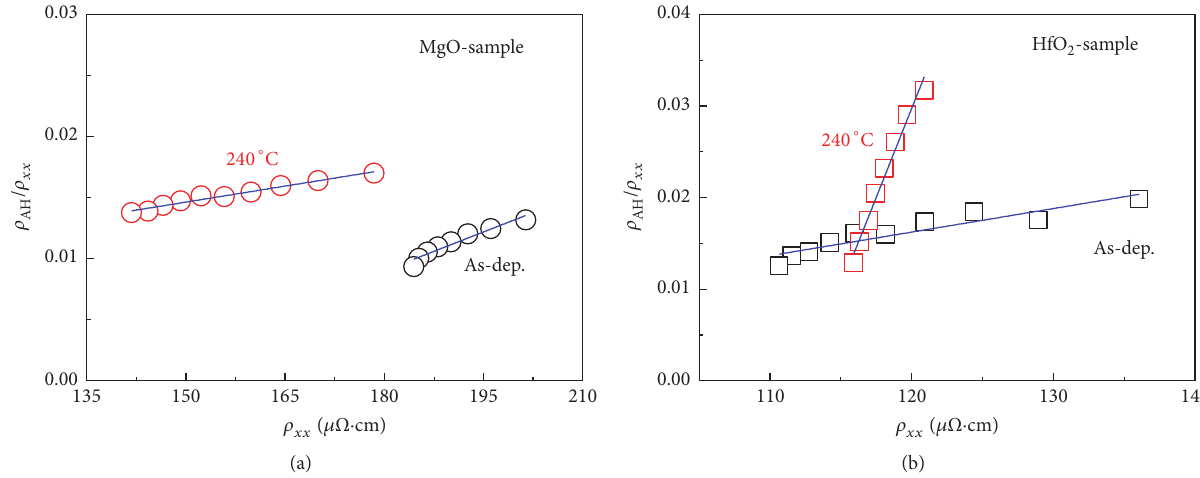
Figure 5: (a) 𝜌 AH /𝜌 𝑥𝑥 versus 𝜌 𝑥𝑥 for sample Ta(0.8)/Co 20 Fe 80 (0.8)/MgO(0.8)/Ta(1.0) (in nm) in the as-deposited and 240 ∘ C annealed states. (b) 𝜌 AH /𝜌 𝑥𝑥 versus 𝜌 𝑥𝑥 for sample Ta(0.8)/Co 20 Fe 80 (0.8)/HfO 2 (0.8)/Ta(1.0) (in nm) in the as-deposited and 240 ∘ C annealed states.